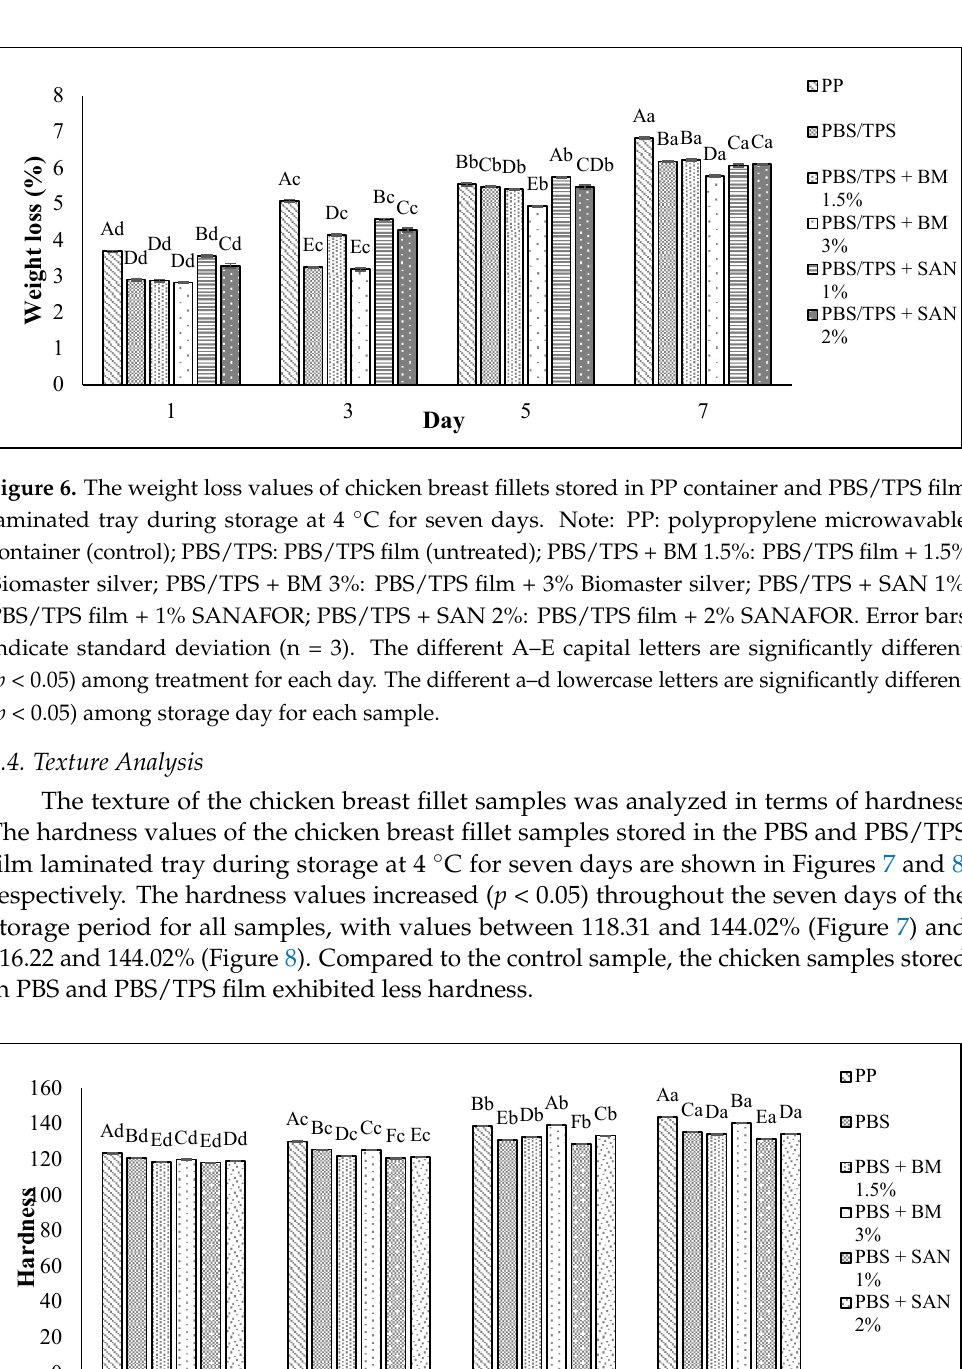
Figure 5. The weight loss values of chicken breast fillets stored in PP container and PBS film lami- nated tray during storage at 4 °C for seven days. Note: PP: polypropylene microwavable container (control); PBS: PBS film (untreated); PBS + BM 1.5%: PBS film + 1.5% Biomaster silver; PBS + BM 3%: PBS film + 3% Biomaster silver; PBS + SAN 1%: PBS film + 1% SANAFOR; PBS + SAN 2%: PBS film + 2% SANAFOR. Error bars indicate standard deviation (n = 3). The different A–F capital let- ters are significantly different ( p < 0.05) among treatment for each day. The different a–d lowercase letters are significantly different ( p < 0.05) among storage day for each sample.